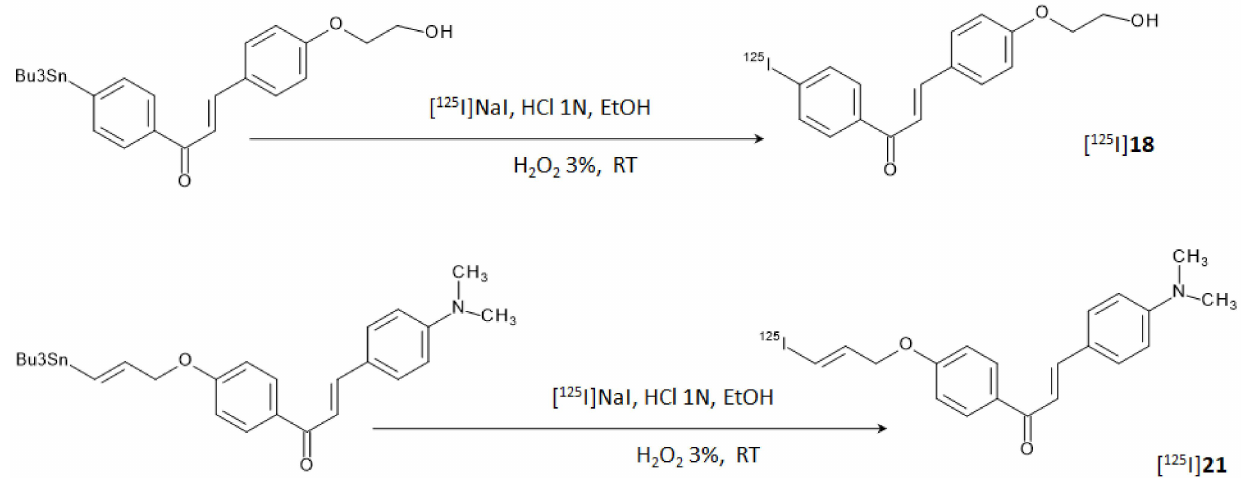
Figure 8. Reaction steps for the labeling of [ 125 I] 18 and [ 125 I] 21